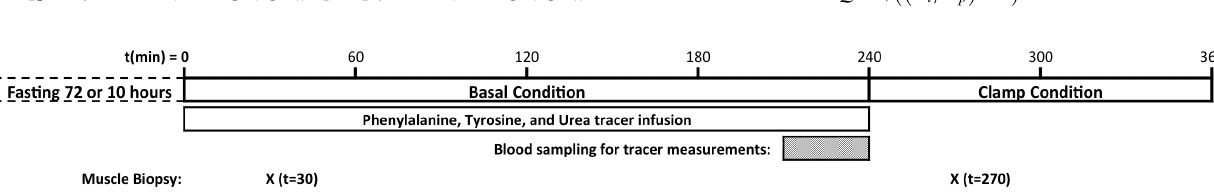
Figure 1. Study protocol. Subjects were examined on 2 separate days in random order: 1) after an overnight fast of 10 hours and 2) after a 72-hour fast. On both experimental days infusions of phenylalanine, tyrosine and urea tracers were initiated at t=0, to measure amino acid kinetics during a 4 hour period ( t =0–240), followed by a 2-hour hyperinsulinemic euglycemic clamp (t=240–360). At t =30 and 270 min, a muscle biopsy was obtained from vastus lateralis of the quadriceps femoris